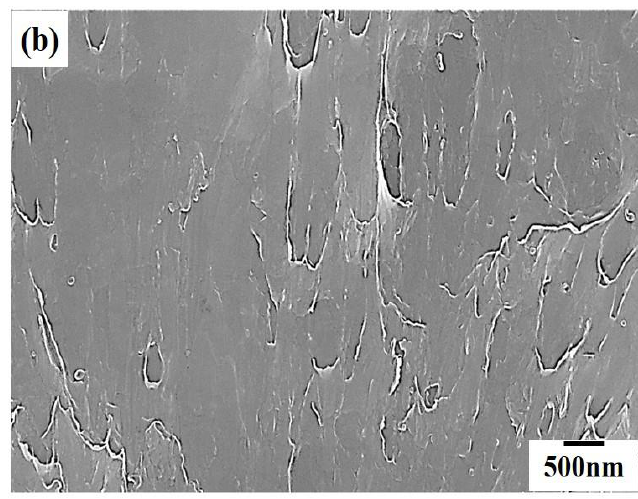
Figure 6. SEM images with high magnification of fractures of 440 specimens after various heat treatments ( a ) 440-NA specimen, ( b ) 440-W specimen.